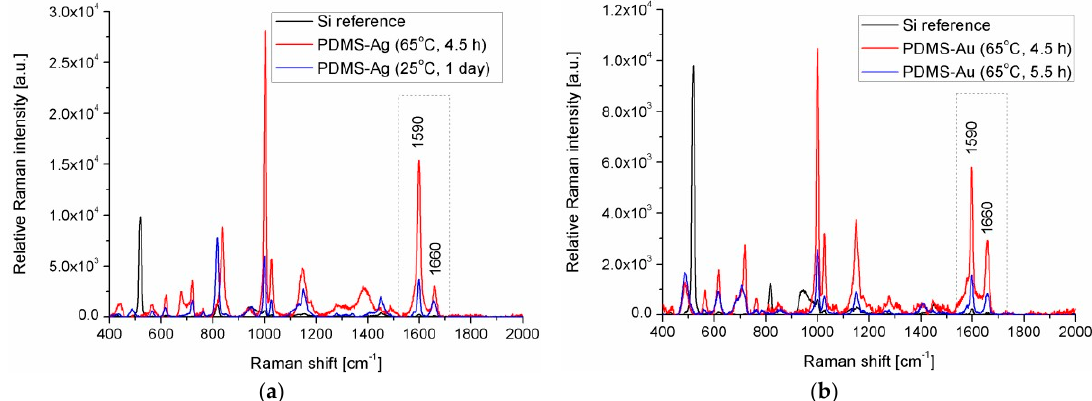
Figure 4. ( a ) Raman (Si reference) and SERS (PDMS-Ag nanocomposites) spectra of the of